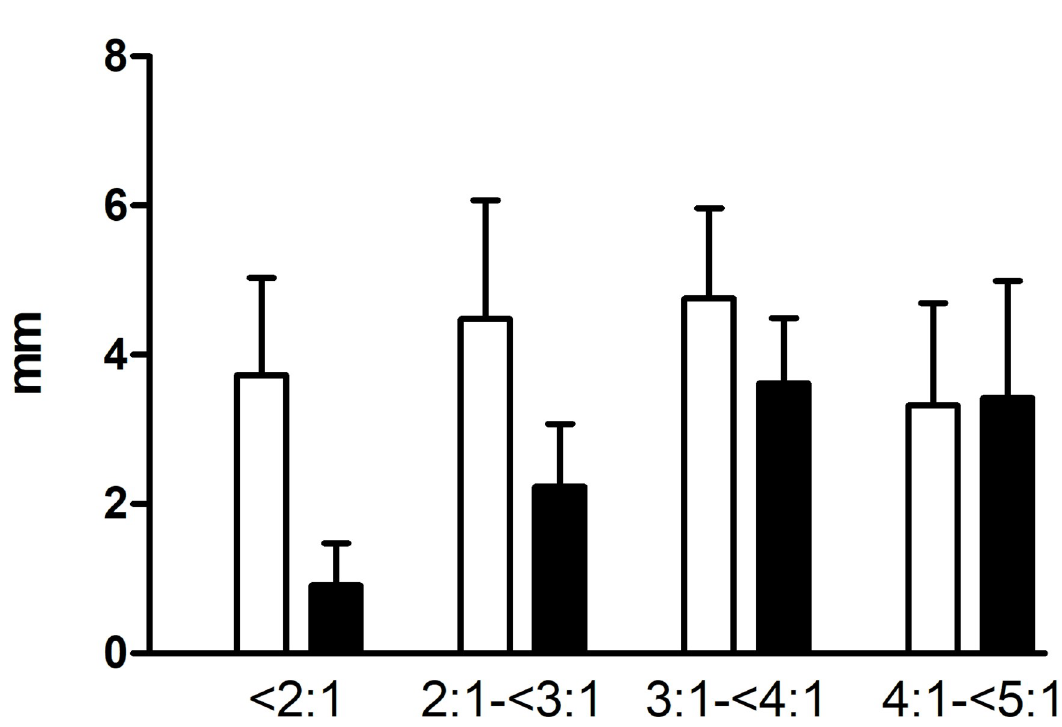
Fig 3. 75 abdominal midline closure measurements in cats categorized by SL:WL ratios < 2:1, 2:1- < 3:1, 3:1- < 4:1, and 4:1- < 5:1 analyzed for the mean SI ± SD and mean TB ± SD.